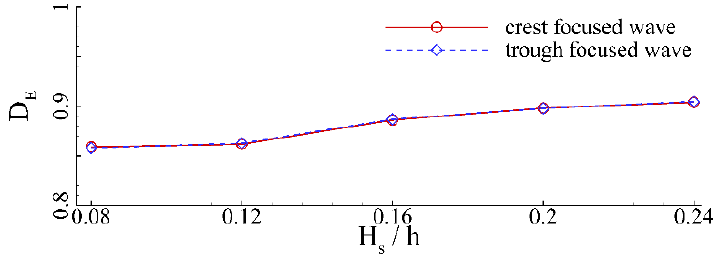
Figure 23. Wave energy dissipation rate versus the relative significant wave height.